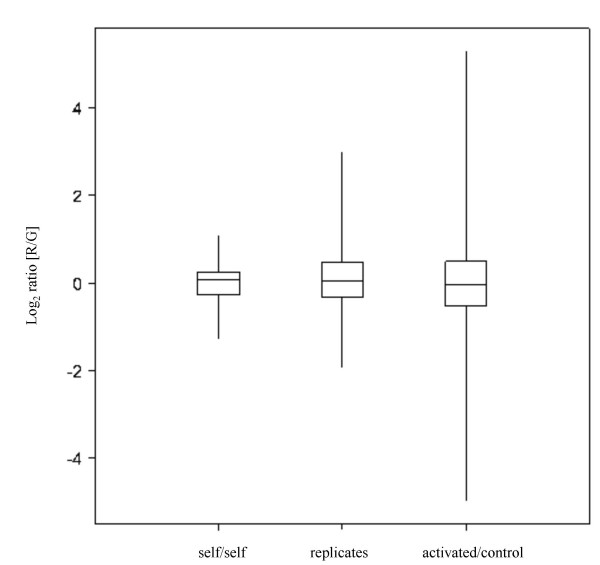
Box plots showing the variance between self/self hybridisation, two biological replicates and a control sample compared with an activated sample. Boxes represent the interquartile range from 25–75%, with the median marked. Outliers to this range are also shown.